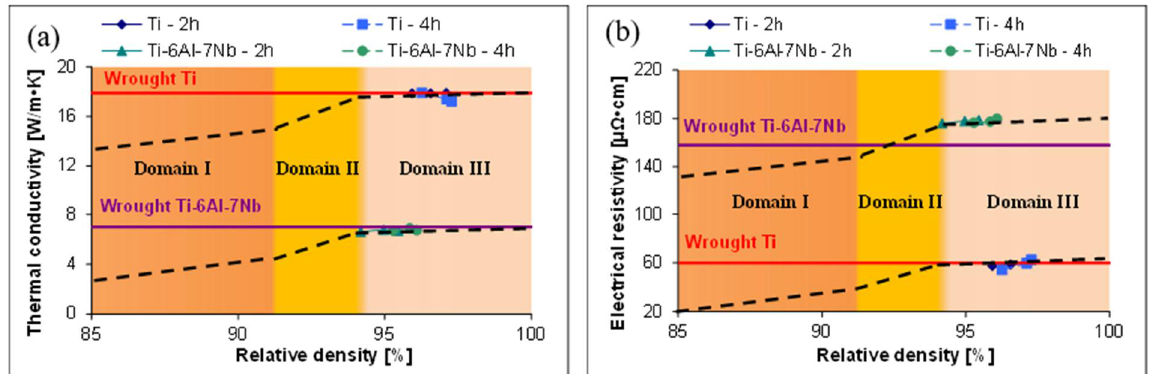
Figure 5. Variation of the thermal conductivity ( a ) and electrical resistivity ( b ) of the P/M Ti and Ti-6Al-7Nb alloy as a function of the relative density.